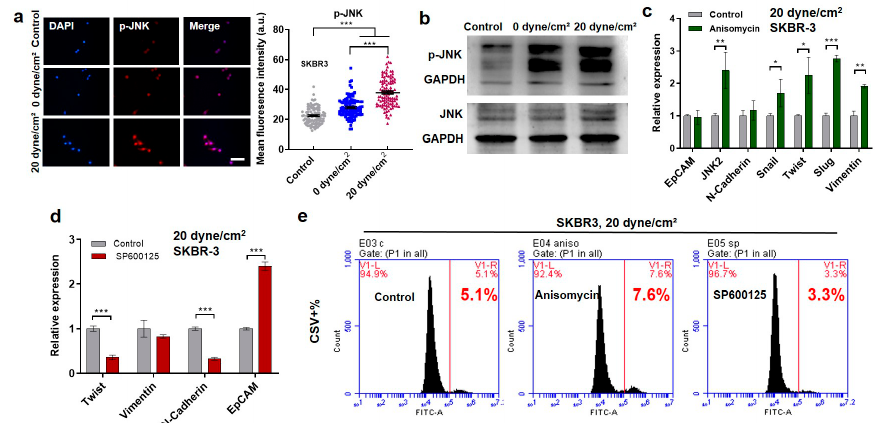
Figure 3. Fluid shear stress facilitates the EMT phenotype of suspended tumor cells via Jun N-terminal kinase (JNK) signaling. ( a , b ) Fluid shear stress activates JNK signaling. SKBR3 cells were treated under 0 and 20 dyne/cm 2 shear stress for 12 h. The total and phosphorylated amounts of JNK were examined by immunofluorescence ( a ) , scale bar in ( a ) 50 µm and western blotting ( b ). n > 100 cells in ( a ); ( c ) Activating JNK signaling upregulated mesenchymal genes under fluid shear stress; ( d ) Inhibiting JNK signaling downregulated mesenchymal genes and upregulated epithelial genes under fluid shear stress; ( e ) JNK signaling regulated the shear-induced EMT. SKBR3 cells were circulated under 20 dyne/cm 2 shear stress in the presence of JNK activator Anisomycin or inhibitor SP600125 for 12 h. The gene expression was examined in ( c ) and ( d ), and the fraction of CSV+ cells was measured in ( e ). n = 2 in ( e ). * p < 0.05; ** p < 0.01; *** p < 0.001.